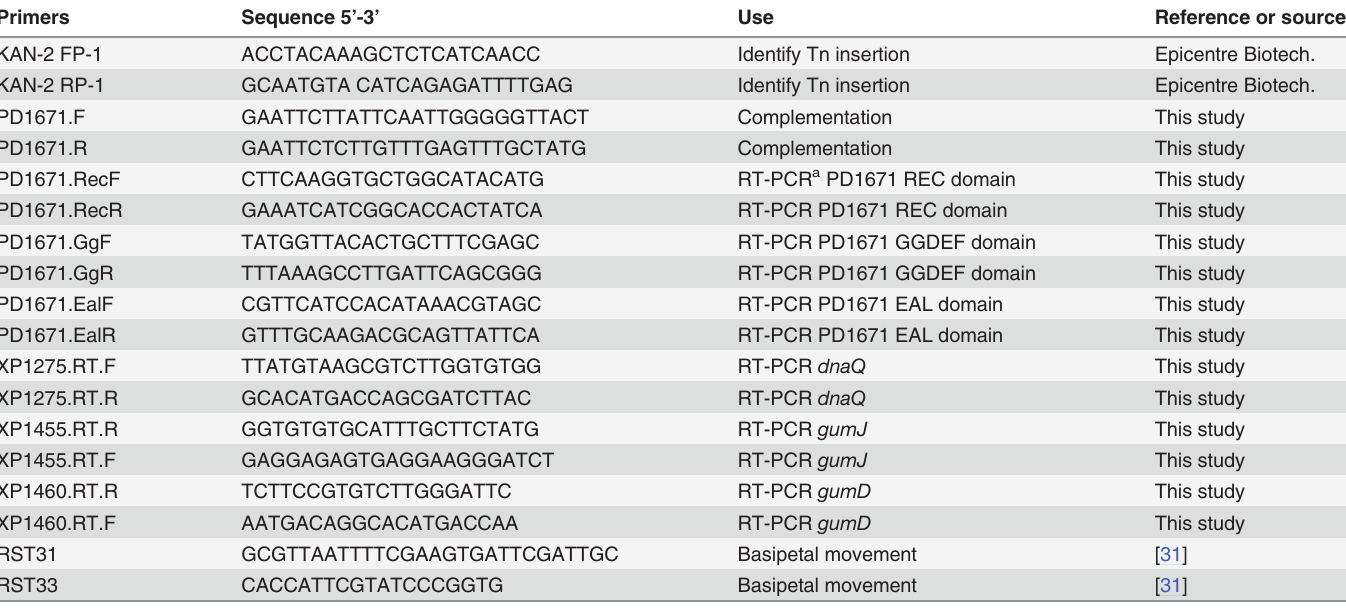
Table 1. Oligonucleotide primers used in this study.